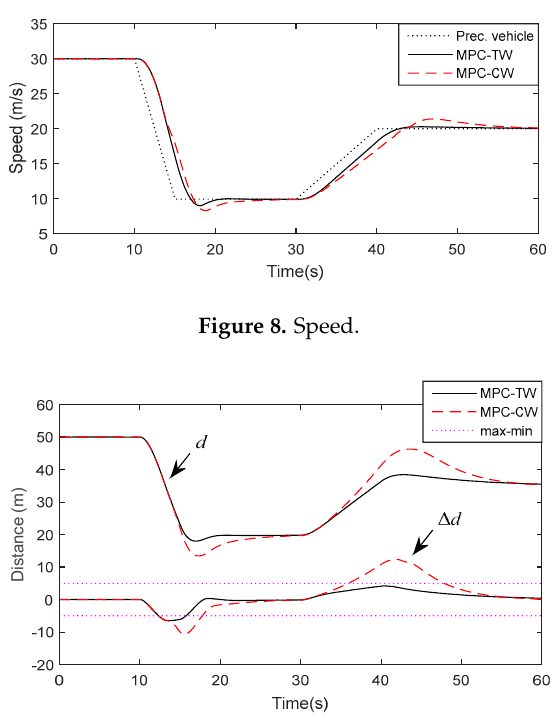
Figure 8. Speed. Figure 8. Speed.